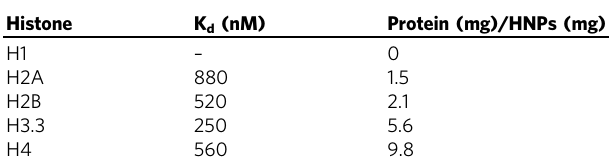
Table 2 Binding af fi nity ( K d ) and capacity of HNP4 against puri fi ed histone